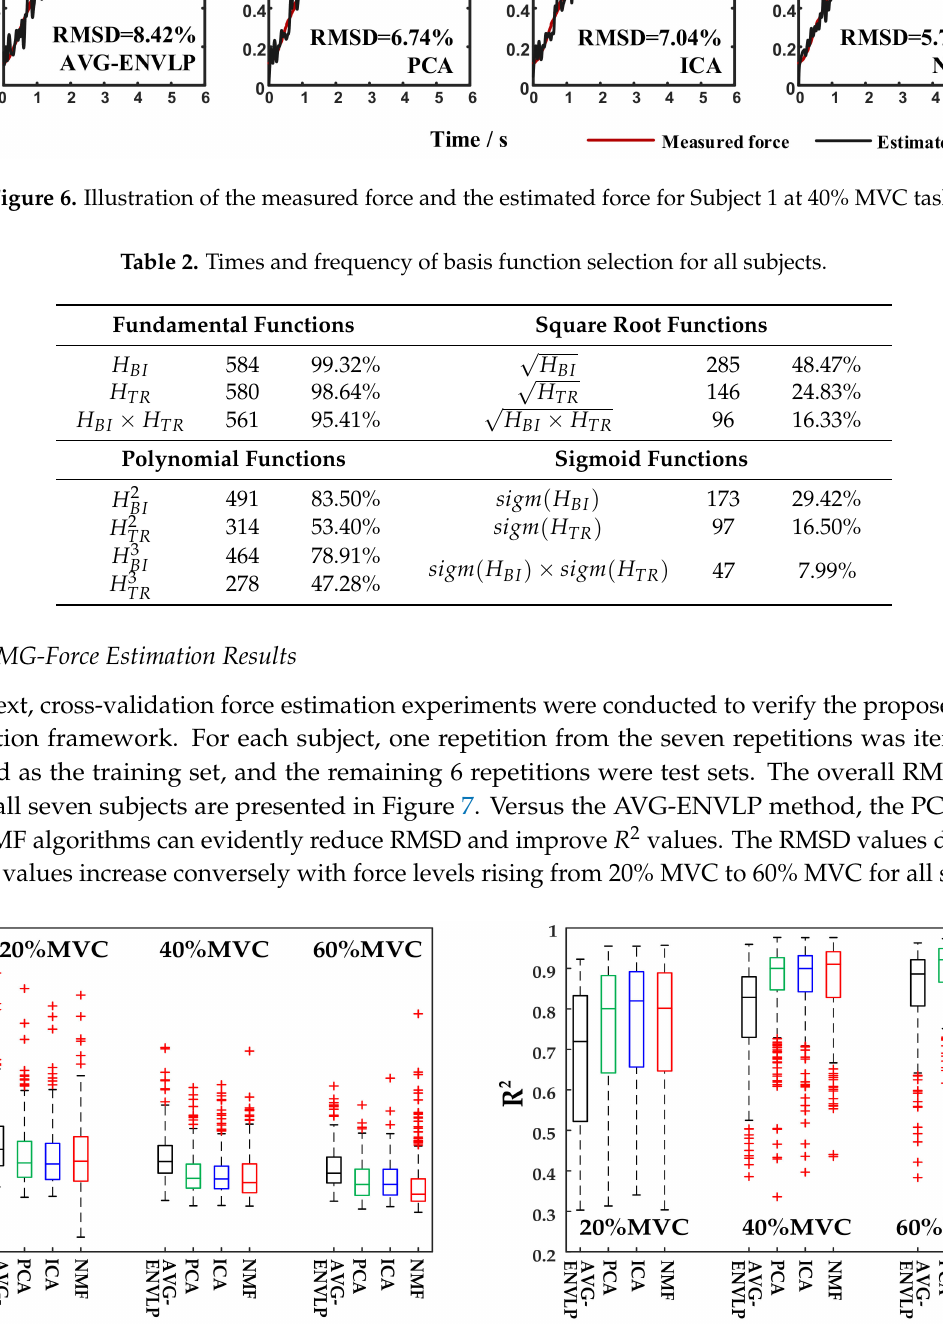
Figure 7. HD-SEMG-based force estimation results for all